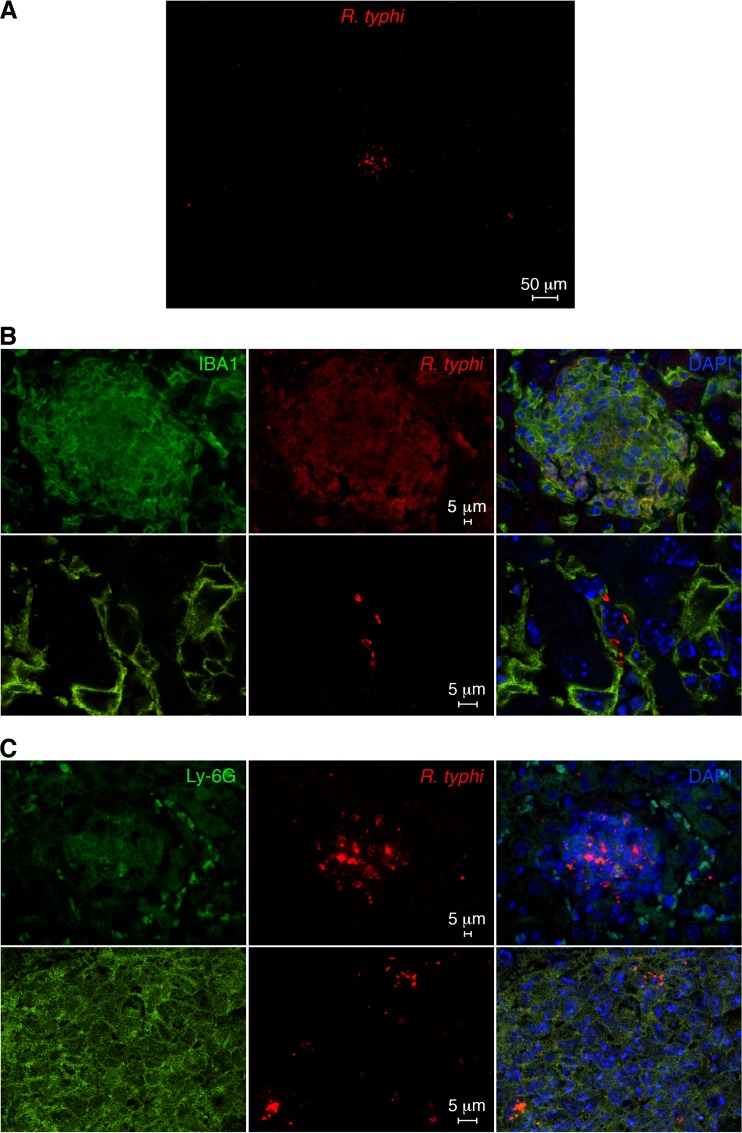
Detection of R. typhiGFPuv in histological sections of liver from a moribund infected CB17 SCID mouse. (A) R. typhiGFPuv bacteria were detected in liver sections from a moribund infected CB17 SCID mouse by staining with anti-GFP antibody (red). An overview image is shown. (B) Sections were further stained with DAPI (nucleus; blue) and for IBA1 (green). Shown are confocal images (bottom) and overlays (right). (C) In addition, sections were stained with DAPI (blue) and for Ly-6G (green). Shown are confocal images (bottom) and overlays (right).